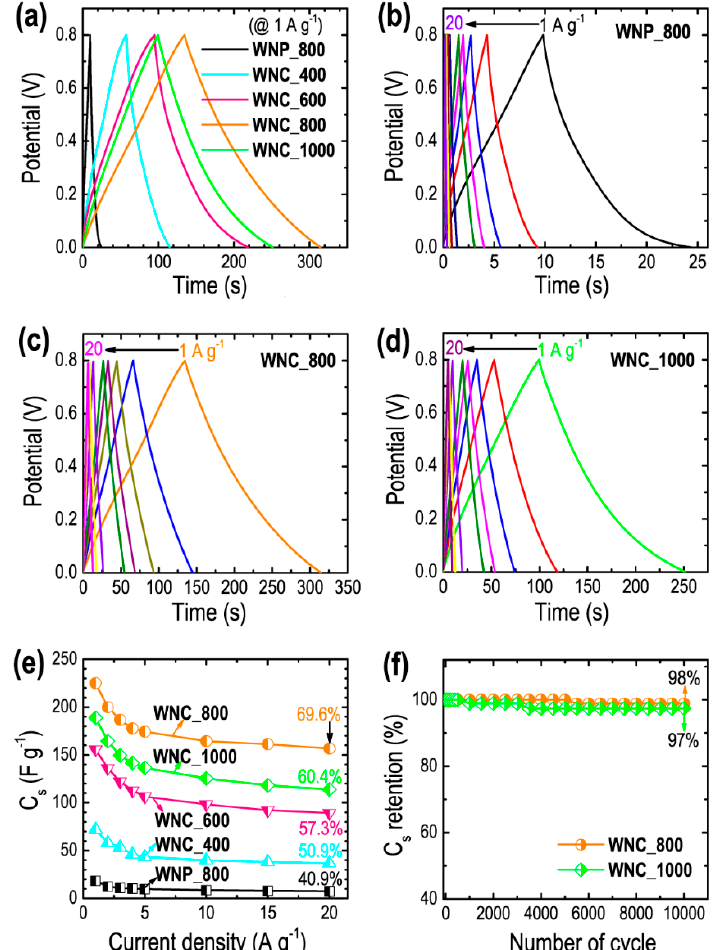
Figure 6. ( a ) Charge-discharge (CD) curves of WNP_800, WNC_400, WNC_600, WNC_800, and WNC_1000 at a constant current density of 1 A g − 1 , CD profiles vs. current density for ( b ) WNP_800, ( c ) WNC_800, and ( d ) WNC_100 as typical examples, ( e ) specific capacitance ( C s ) vs. current density, and ( g ) cycling stability performances of the WNC_800 and WNC_1000 electrodes for 10,000 cycles as typical example.